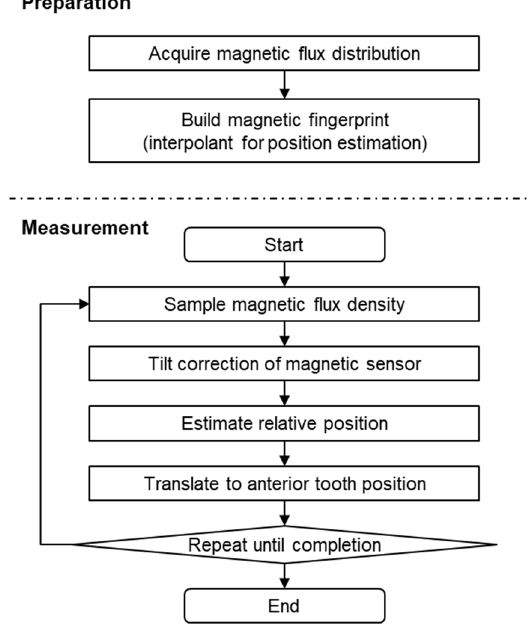
Figure 4. Measurement and data processing flow diagram.